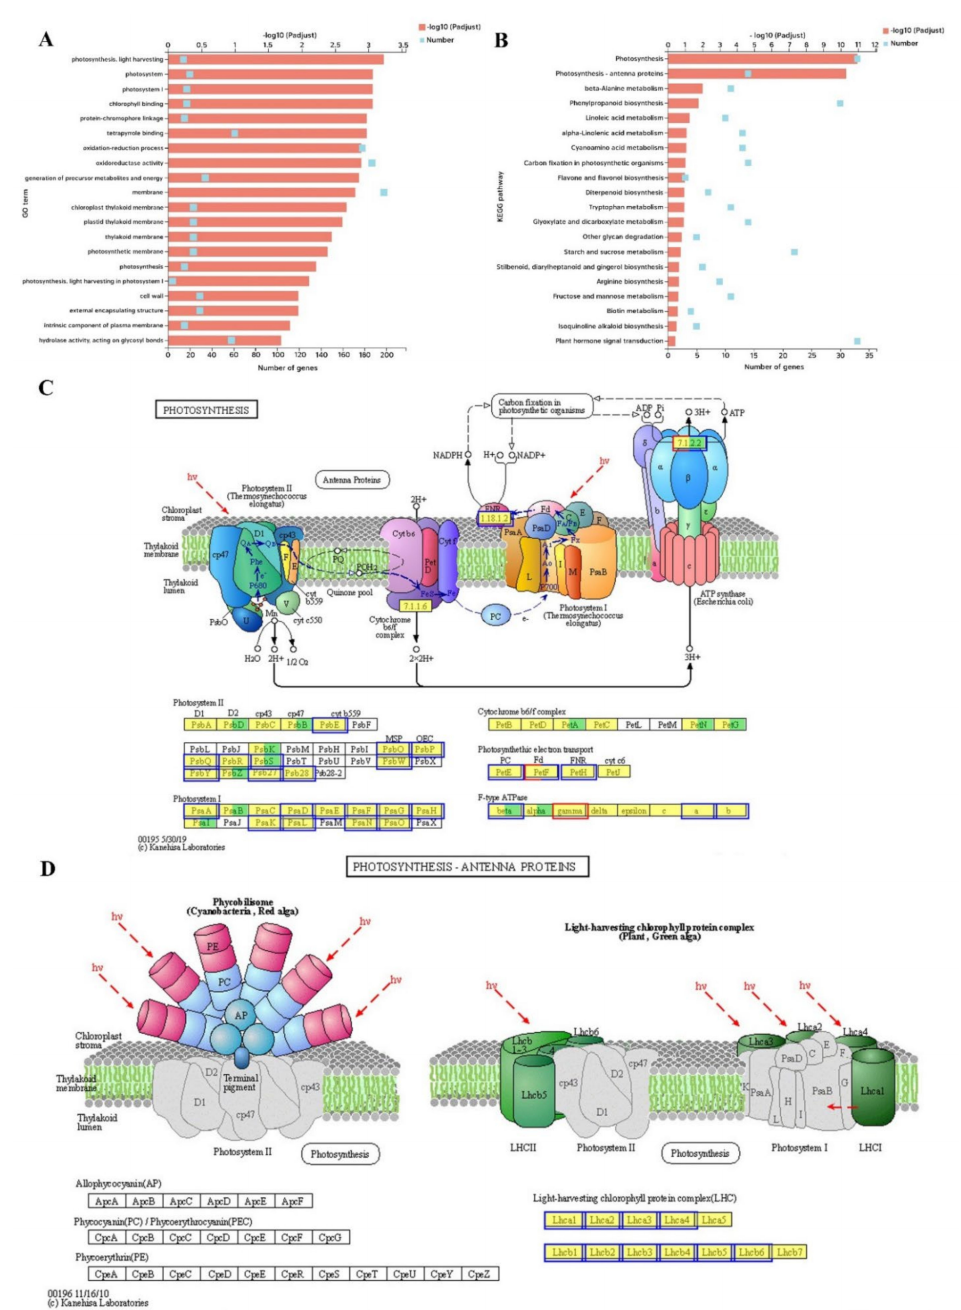
Figure 7. GO and KEGG functional enrichment analysis under low-Pi stress. ( A ) Top 20 GO terms of DEG enrichment under low-Pi stress. ( B ) Top 20 KEGG pathways of DEG enrichment under LP stress. ( C ) Schematic diagram of photosynthesis KEGG pathway. The yellow and green backgrounds indicate the known and new genes, respectively. The red and blue borders indicate the up- and downregulated genes, respectively. ( D ) Schematic diagram of photosynthesis-antenna proteins KEGG pathway. The yellow backgrounds indicate the known genes. The blue borders indicate the downregulated